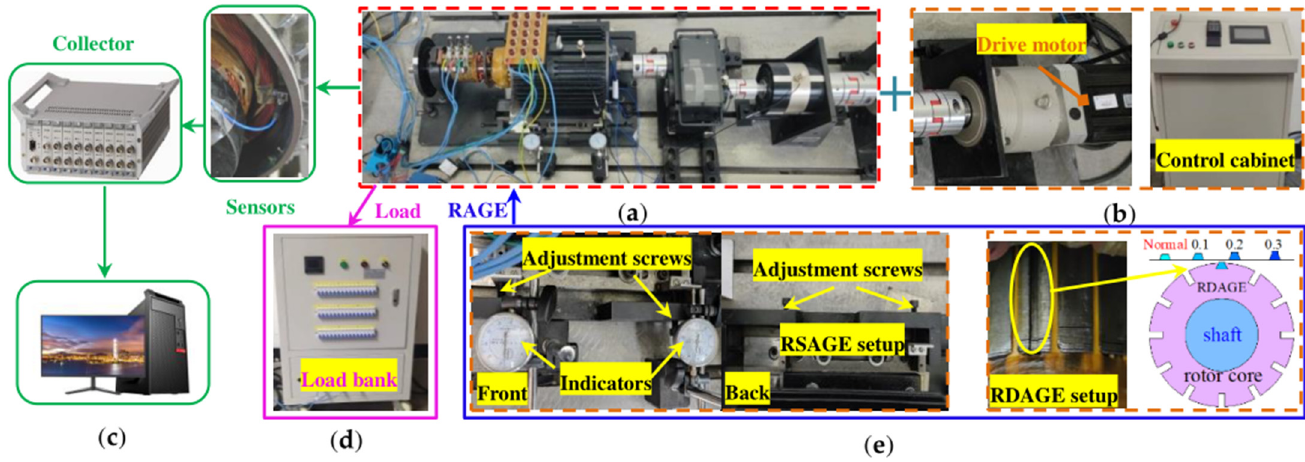
Figure 4. Experimental setup: ( a ) DFIG; ( b ) drive motor and control cabinet; ( c ) acquisition equipment; ( d ) load bank; and ( e ) RAGE setup.